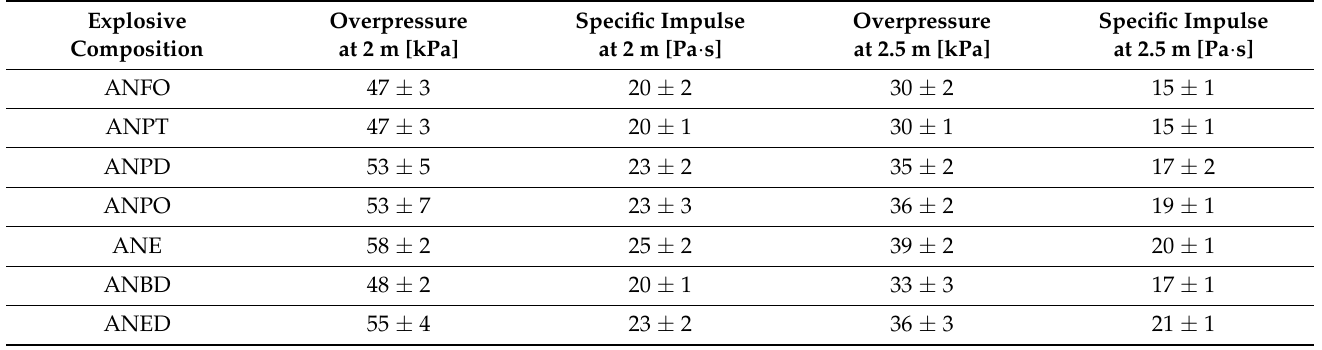
Table 8. Results of measurements of blast waves characteristics of AN/organic fuel compositions.